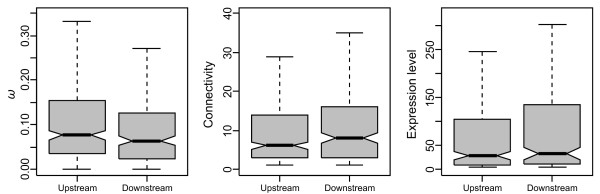
Comparison of genes encodingthe upstream and downstreamproteins of the humansignal transduction network.